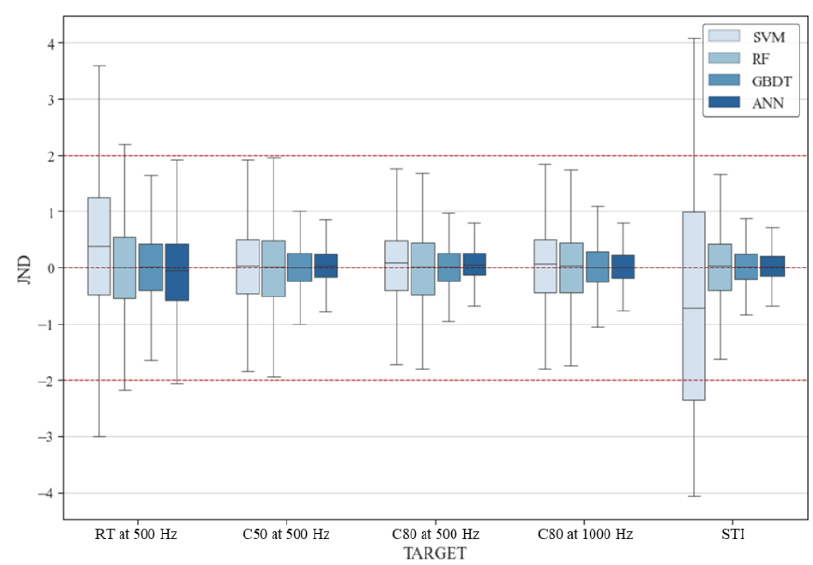
Figure 20. JND of each model with testing set (outliers not shown).